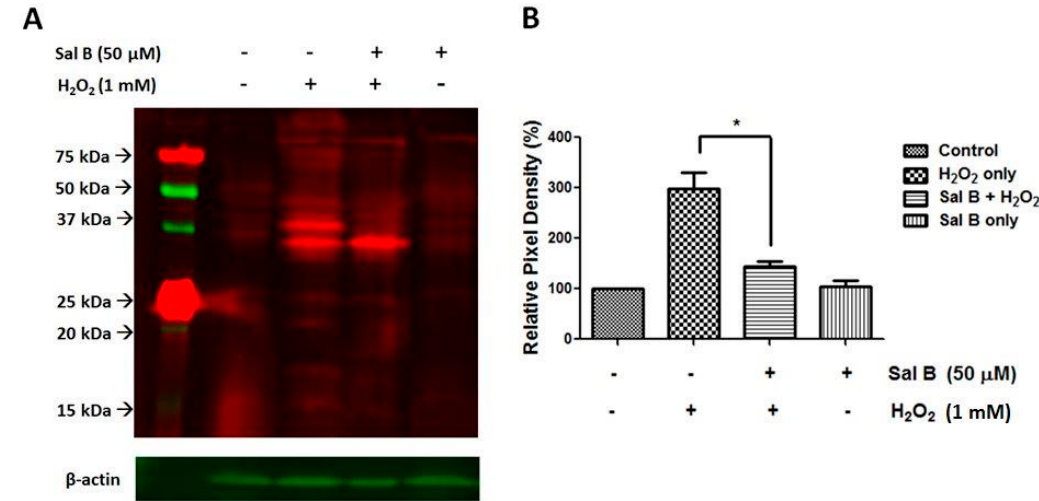
Figure 4. Sal B inhibits protein-glutathione mixed disulfide (PSSG) accumulation. ( A ) PSSG levels were detected by using Western blot. Cells were pretreated with or without 50 μ M Sal B for 24 h followed by 1 mM H 2 O 2 for 30 min. Total proteins were separated on a 12% SDS-gel under non-reducing condition (no β -mercaptoethanol) for Western blot analysis using an anti-PSSG antibody; PSSG bands were in red and actin bands were in green; ( B ) the relative pixel density of all the PSSG bands compared to β -actin. Data are mean ± SEM of three independent experiments, * p < 0.05 compared with the H 2 O 2 -only group ( n = 3).